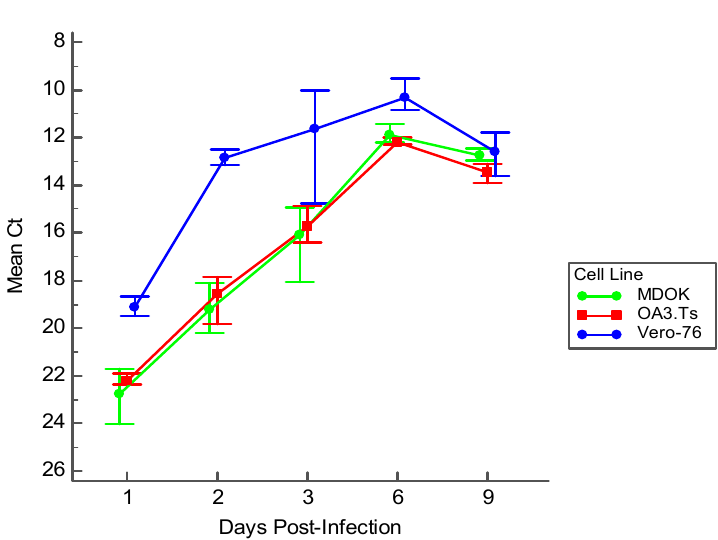
Figure 7. Viral kinetics of ZIKV in immortalized sheep cells measured by RT-PCR by DPI. Each point for each cell line represents the mean cycle threshold (Ct) of the three experimental replicates at each time point; error bars represent the range of Ct values in each replicate group.